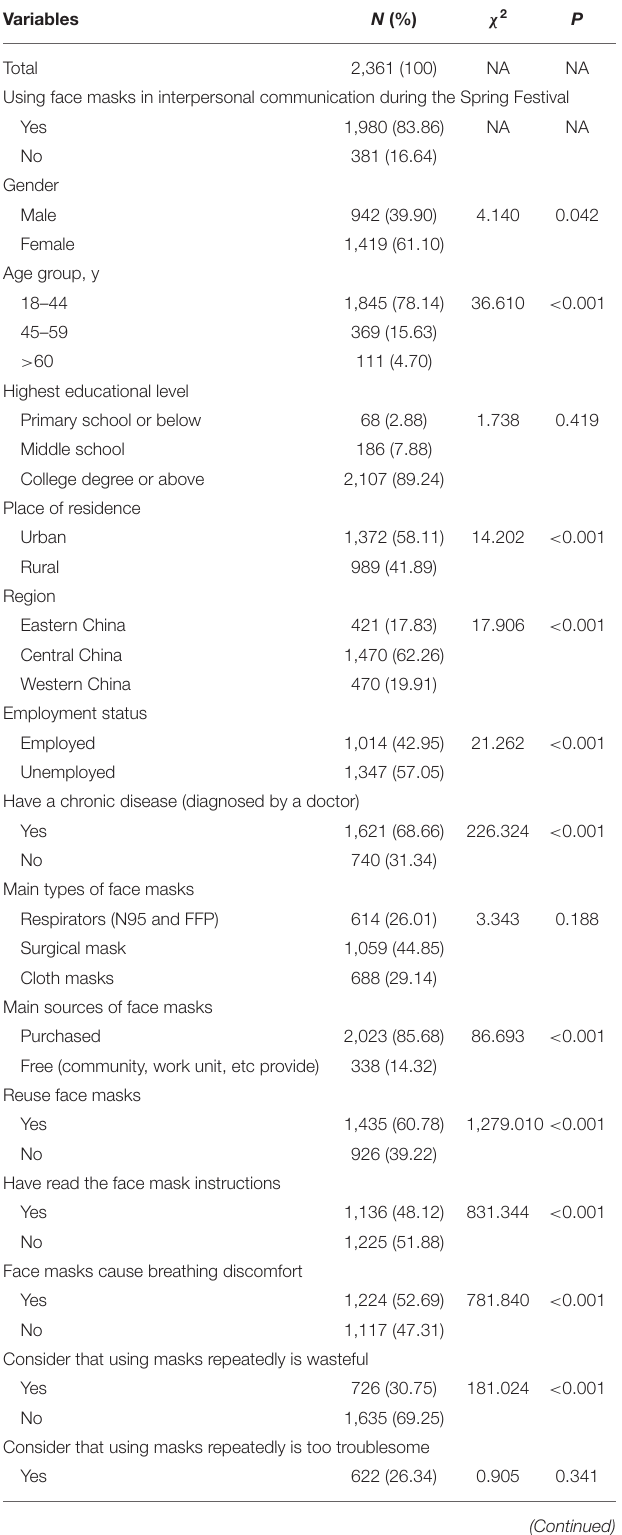
TABLE 1 | The statistical description of the study samples: univariate analysis of the differences of the willingness of residents to use face masks in their interpersonal communication during the Spring